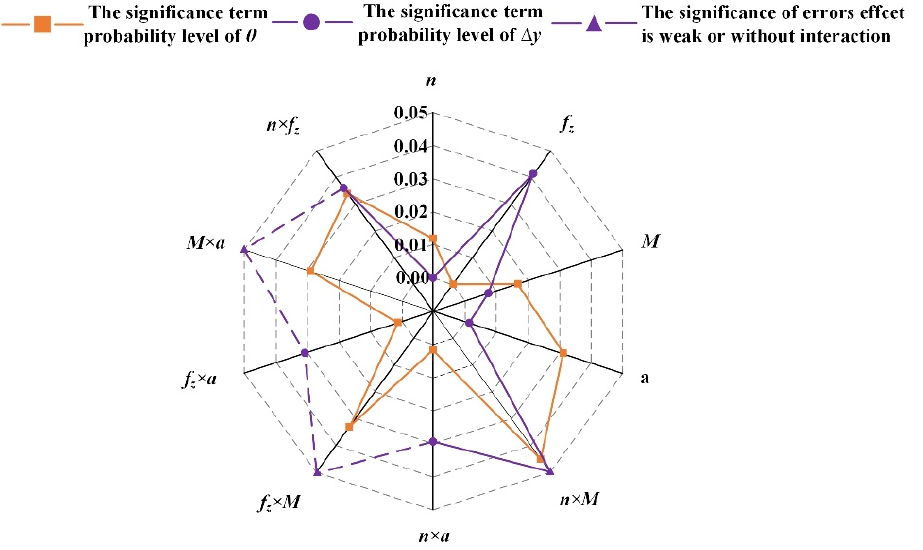
Figure 8. Inherent items of influencing factors of the machined surface error variation characteris- tics.